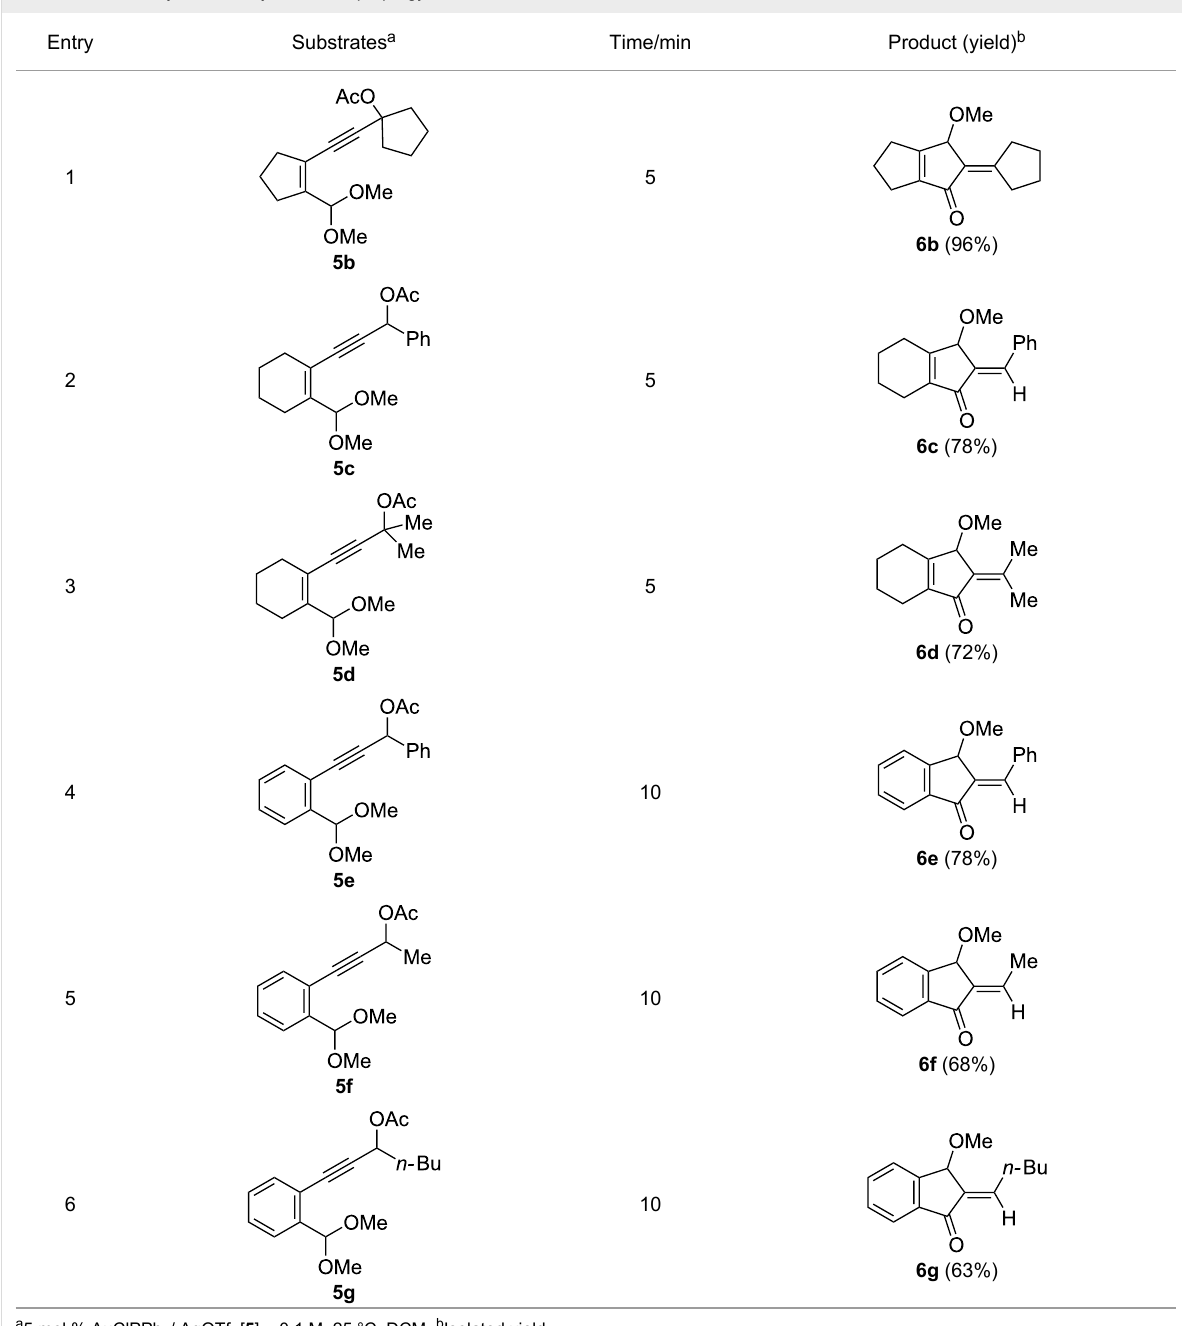
Table 3: Gold-catalyzed carbocyclization of propargylic